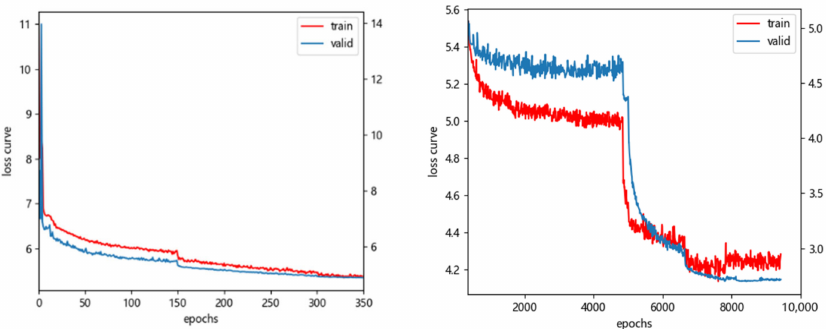
Figure 11. ( Left ) Warm-up training. ( Right ) Official